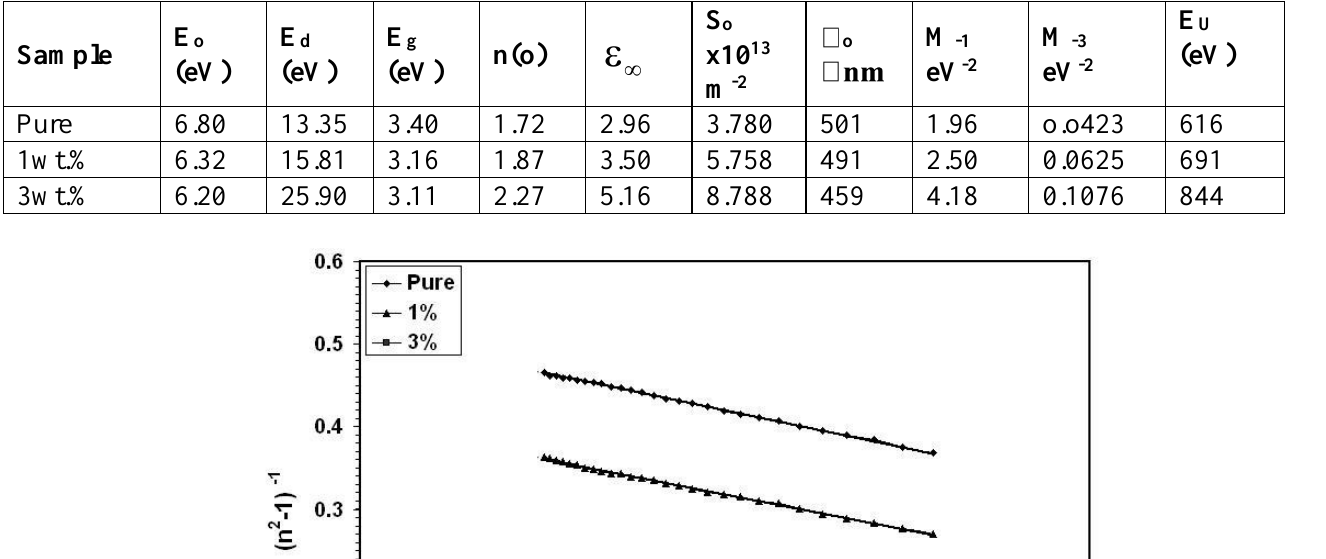
Table 1: The optical parameters.